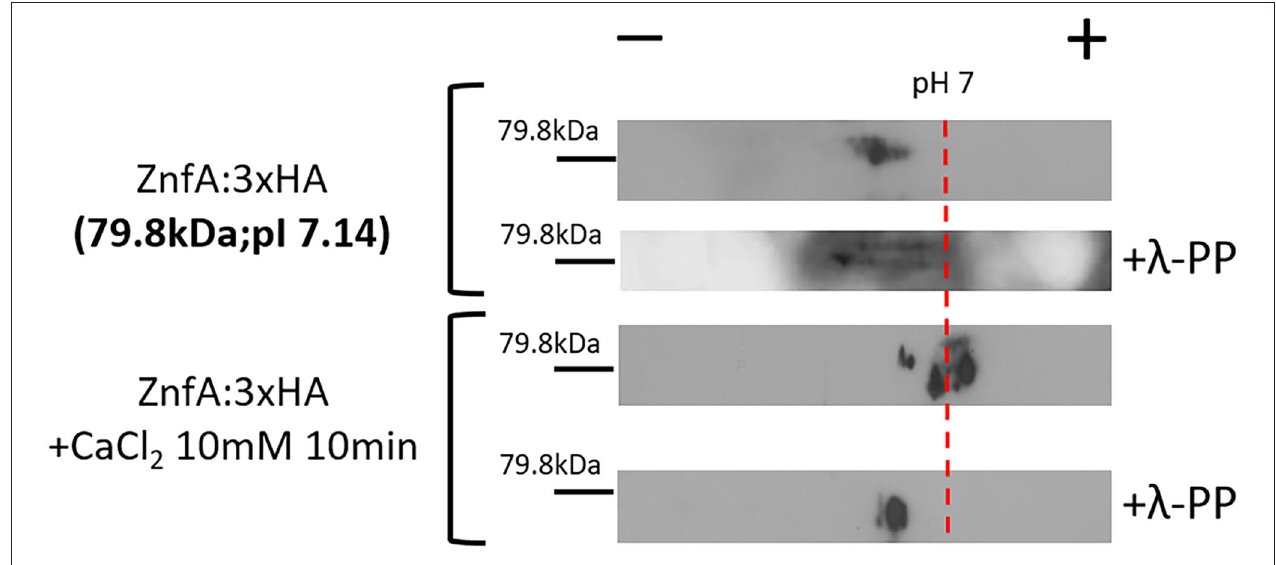
FIGURE 2 | A. fumigatus ZnfA:3xHA is not dephosphorylated upon calcium stress. ZnfA:3xHA strain was grown for 24h at 37 ◦ C and treated or not with CaCl 2 10mM for 10min. Protein extracts were subjected to immunoprecipitation and left untreated or treated with lambda phosphatase ( λ -PP). Bidimensional gel electrophoresis coupled with western blotting was then carried out by using anti-HA antibody against the HA epitope to detect ZnfA:3xHA. pI, isoelectric point.